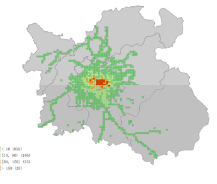
Table 4. Share of emissions and total emissions for each group of grids. Figure 14. ( a ) Grid average carbon emissions (G-avgc) of each grid area at 1:00 a.m.–3:00 a.m. ( b ) Grid average carbon emissions (G-avgc) of each grid area at 7:00 a.m.–9:00 a.m. ( c ) Grid average carbon emissions (G-avgc) of each grid area at 5:00 p.m.–7:00 p.m. ( d ) Grid average carbon emissions (G-avgc) of each grid area at 8:00 p.m.–10:00 p.m.